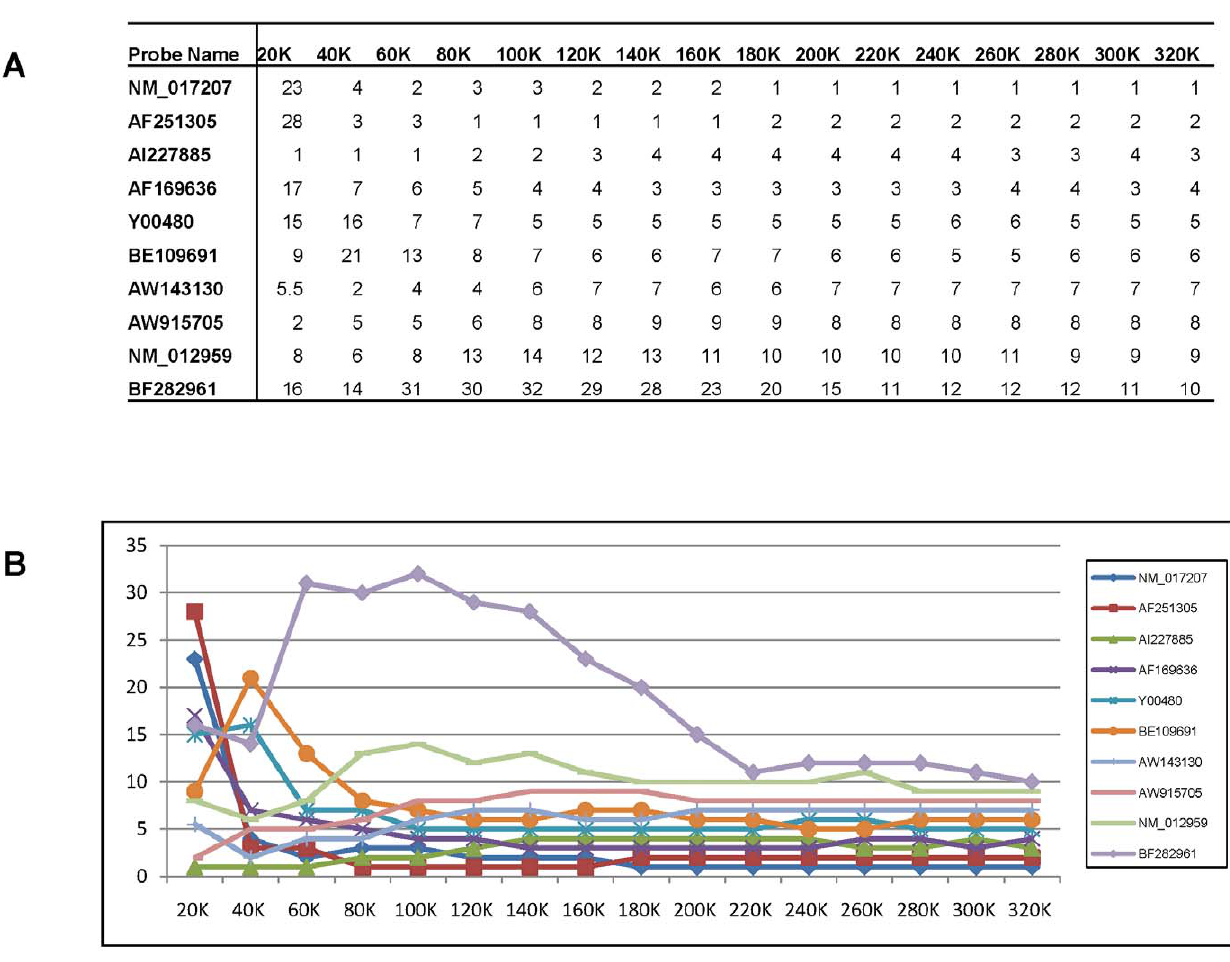
Figure 3. Example of top 10 genes Rank shifting at each checkpoint of the iteration. ( A ) shows that the index of the 10 top-ranked genes (i.e., features) becomes stabilized when the iteration of splitting reached 280k. The rank for 8 out of 10 genes is consistent as early as the iteration reaches to 180k. ( B ) A plot for the same data as shown in ( A ) for an intuitive observation.